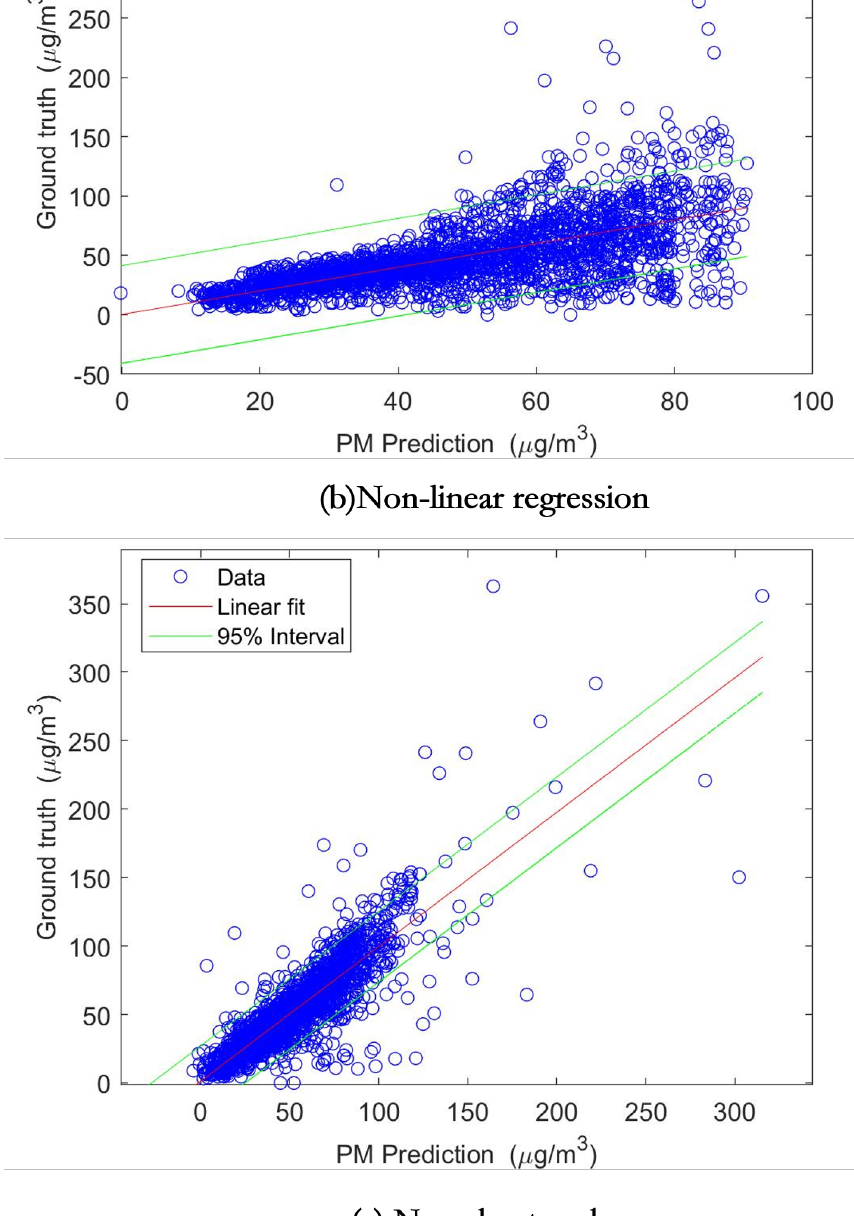
Figure 9. Linear regression lines with red color between estimated PM 2.5 concentrations and the PM 2.5 observation (reference) data. The spaces between the two green lines are the 95% prediction interval.